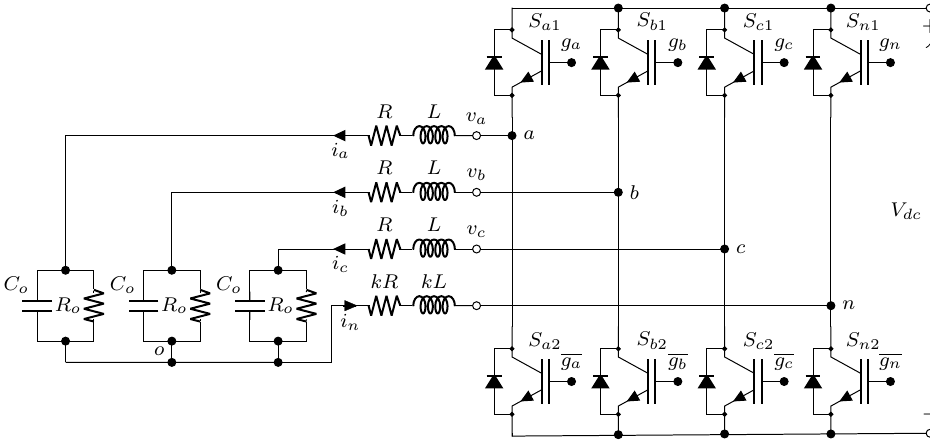
Figure 3. Test circuit scheme of a three-phase, four-leg voltage-source converter with a neutral line inductor connected to an AC load.